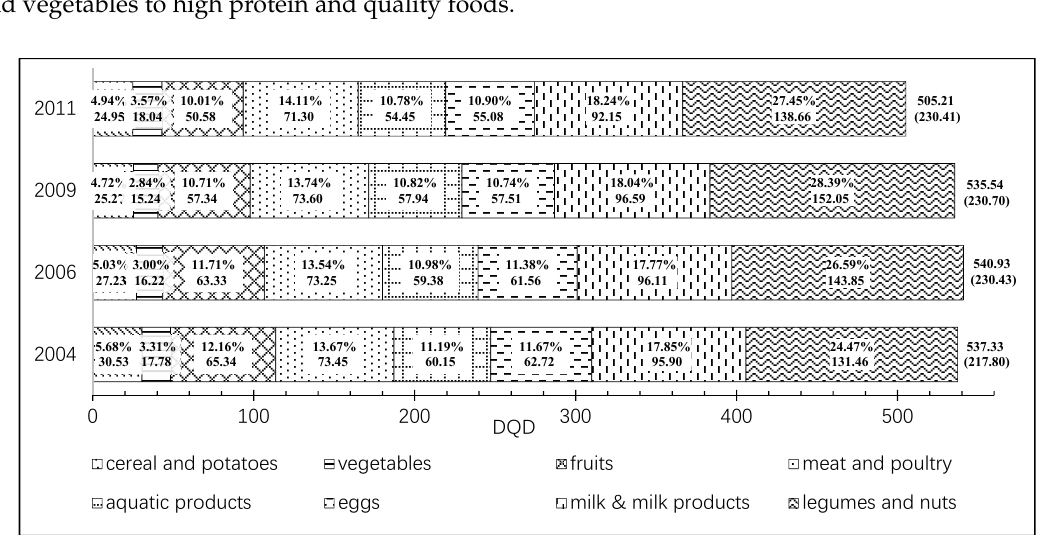
Figure 2. Dynamics of diet quality divergence Index (DQD) and its structure. DQD Change (2011–2004) = − 32.11 (SD = 3.54), p < 0.001.